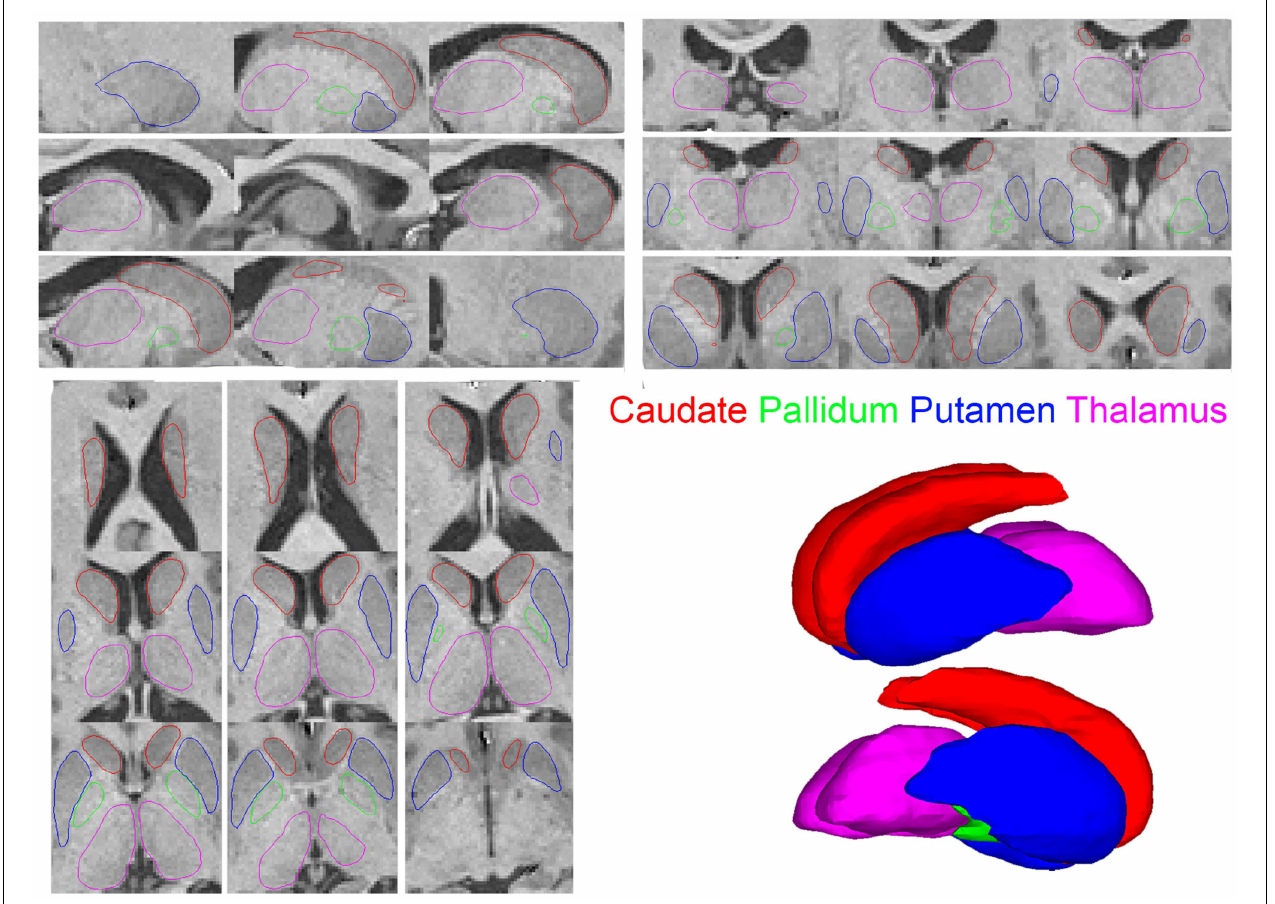
FIGURE 2 | Saggital upper left Coronal upper right Axial lower left views of the segmentation outlines overlayed on the corresponding MRI slices. The 3D surface renderings show the smooth surfaces lower right .